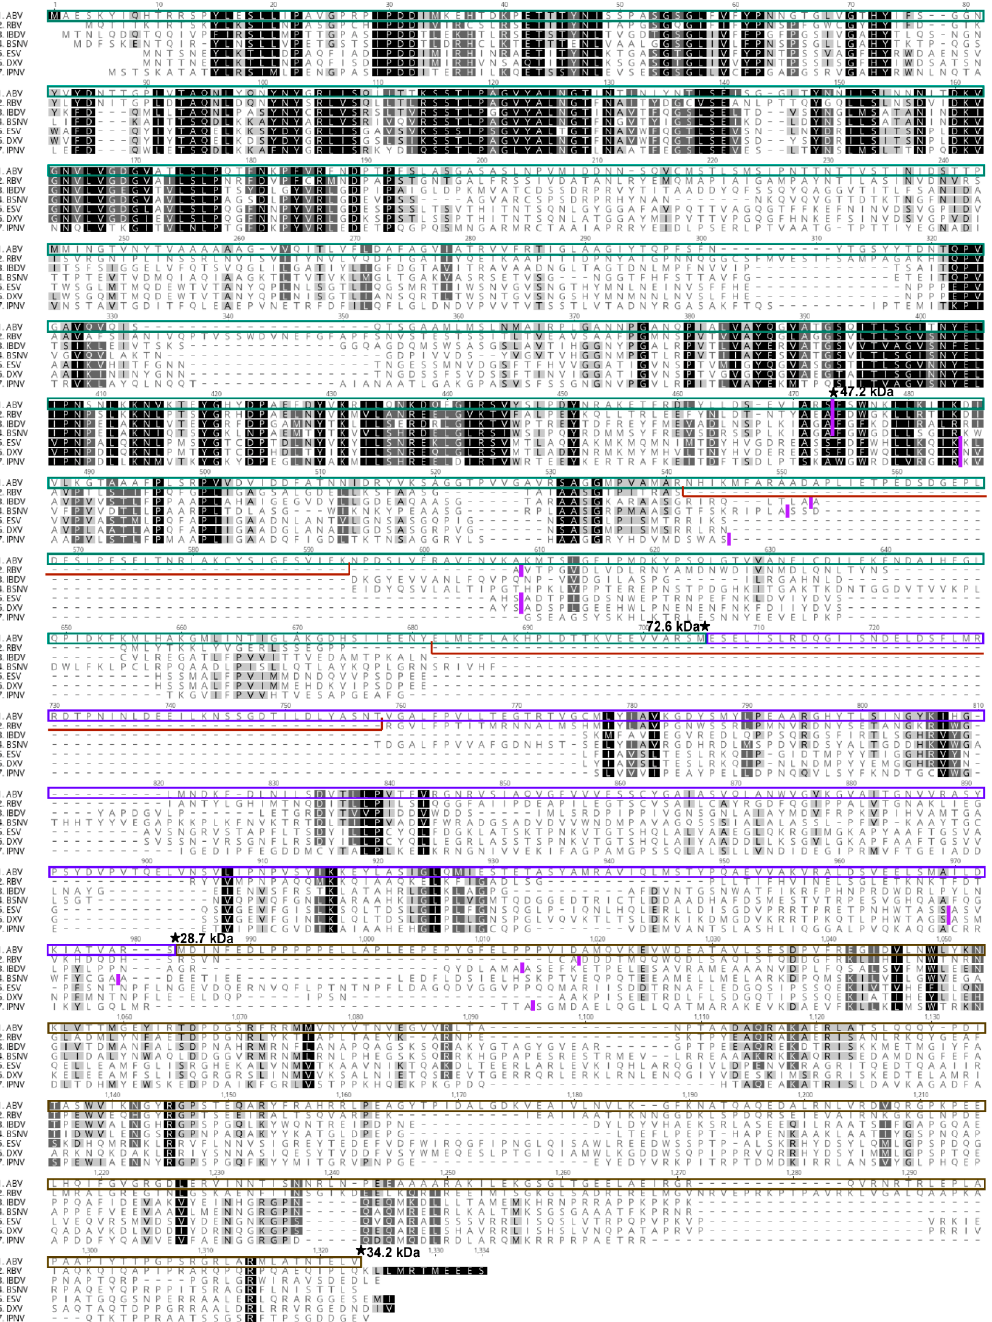
Figure 6. Clustal W alignment of amino acid polyprotein sequences for ABV, RBV (CAX33877), IBDV (ANY27027), BSNV (CAD30689), ESV (AEW87521), DXV (NP_690836) and IPNV (NP_047196). Non-conserved insertions of 61 and 85 amino acids in the ABV polyprotein are indicated by red lines. Vertical lines in magenta depict published polyprotein cleavage sites for these birnaviruses [41,42]. ★ Denotes predicted cleavage sites for ABV based on mass spectrometry data; Molecular weights predicted using ExPASy compute pI/MW tool are marked at the c-terminus of each resulting protein. Green box, pVP2. Purple box, VP4; brown box, VP3.